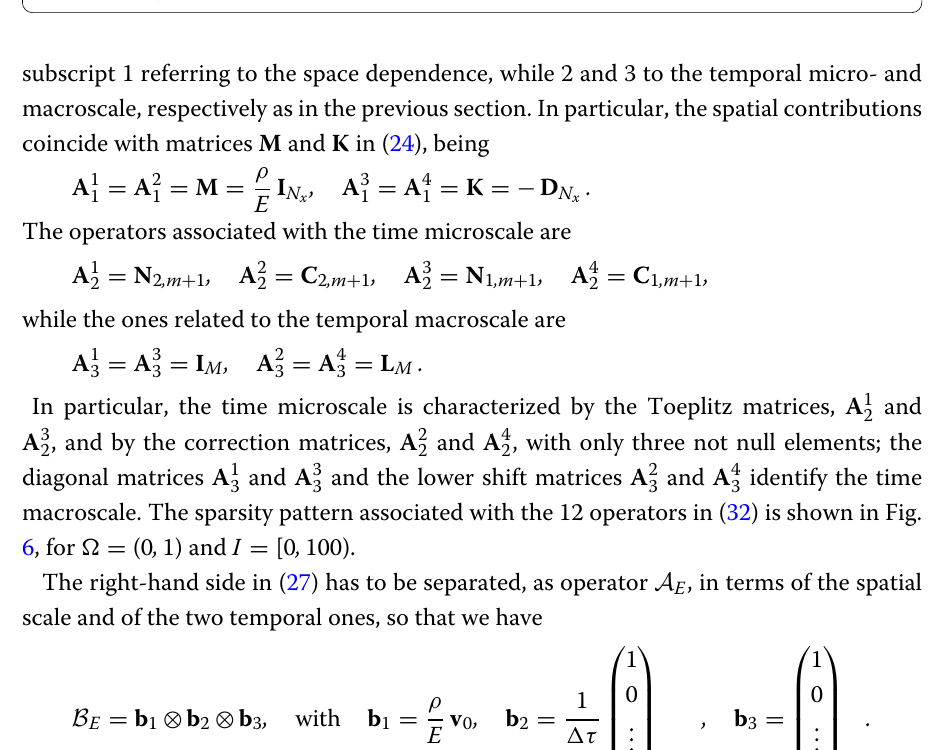
Fig. 5 Sparsity pattern of discrete PGD operators associated with the separated representation (28), for N x = 51 and N t =